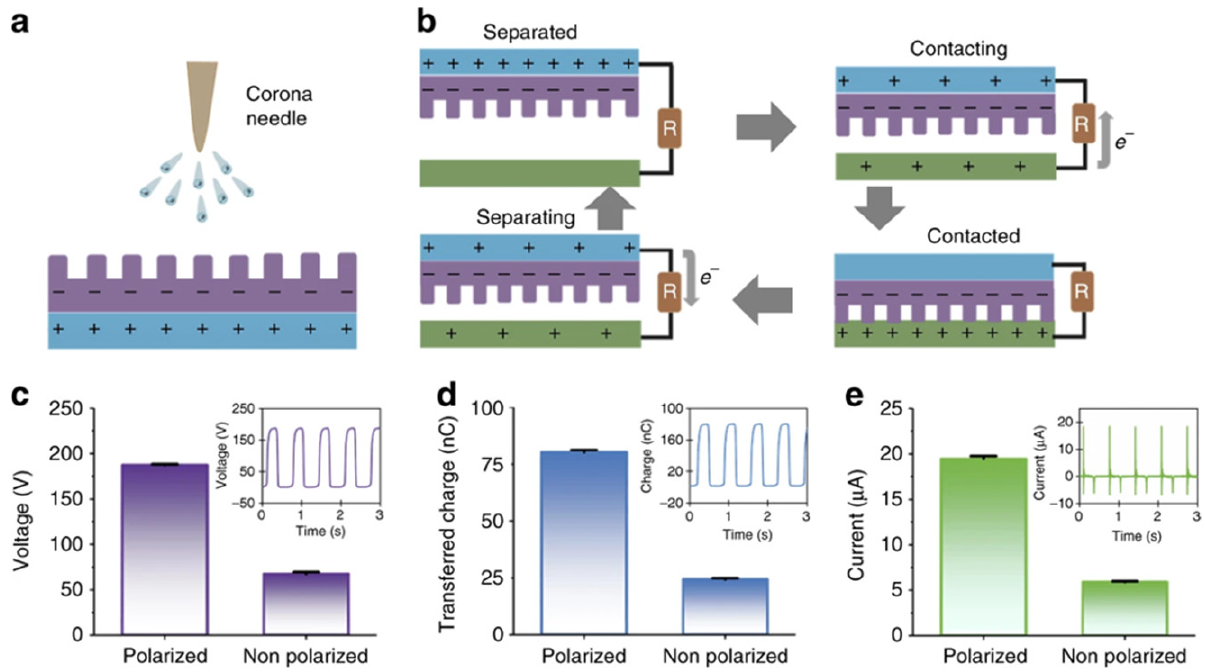
Figure 16. Working mechanism of the PTFE-based iTENG designed by Ouyang et al. [110]. ( a ) Schematic view of a corona discharge system. ( b ) Working mechanism of the iTENG. ( c – e ) Results of electrical performance (output voltage, transferred charge, and current) of the polarized and non- polarized PTFE film considering a linear motor. Reprinted with permission from [110]. Copyright